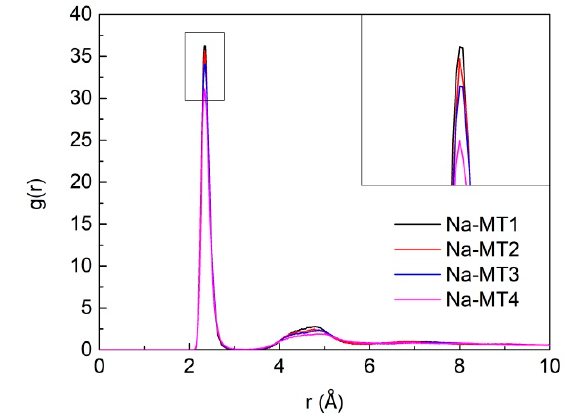
Figure 12. The RDF of Na-O w in Na-MT with different layer charge density.